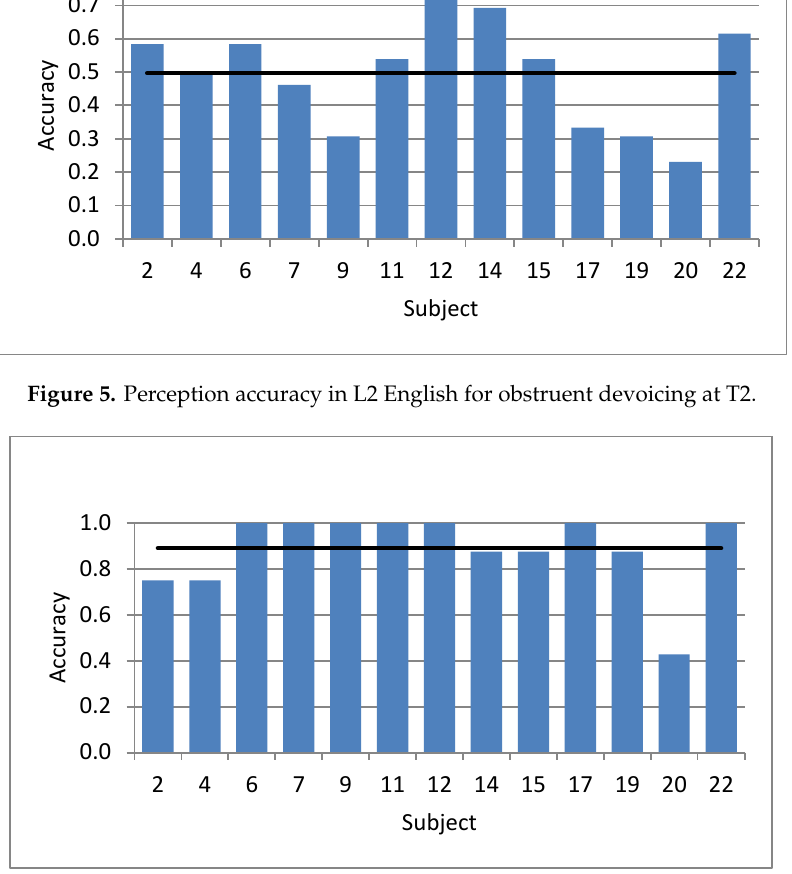
Figure 6. Perception accuracy in L2 English for rhotics at T2.